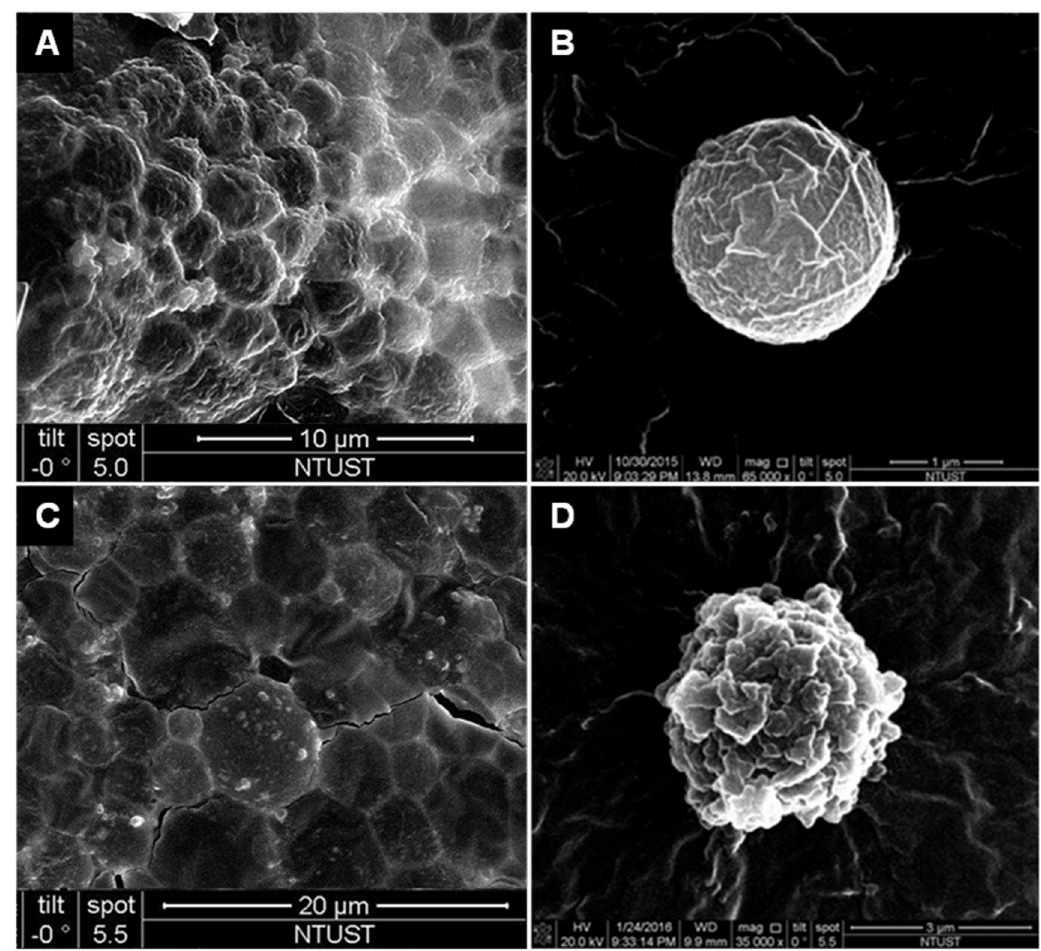
Fig 4. Scanning electron microscopy images of the LysMBs and Ada- LysMBs. (A, C) Multiple LysMBs and Ada-LysMBs, (B, D) single LysMB, and Ada-LysMBs.